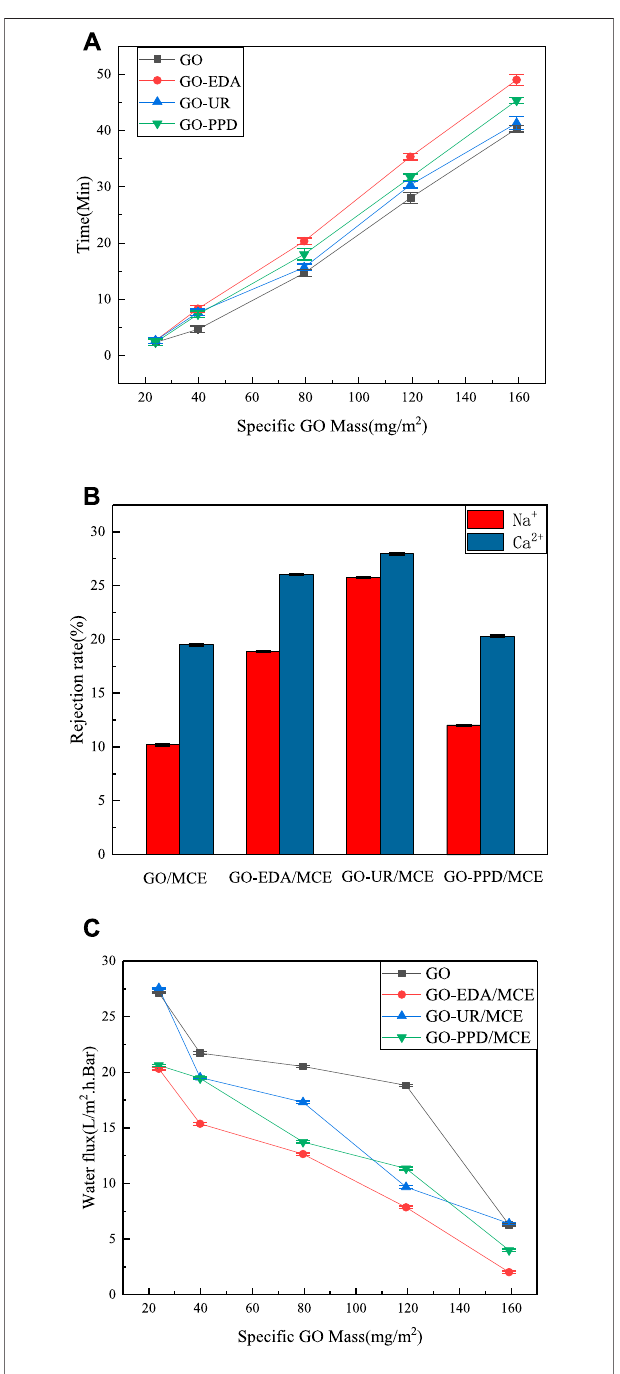
FIGURE9|(A) Timespent fi lteringspeci fi cGOmasses; (B) Ionrejection of GO composite membranes; (C) Water fl ux of GO composite membranes with different speci fi c GO